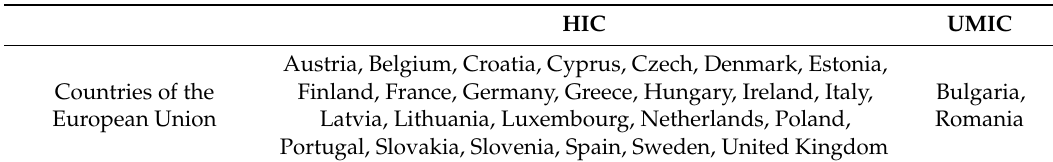
Table A1. Countries of the European Union.